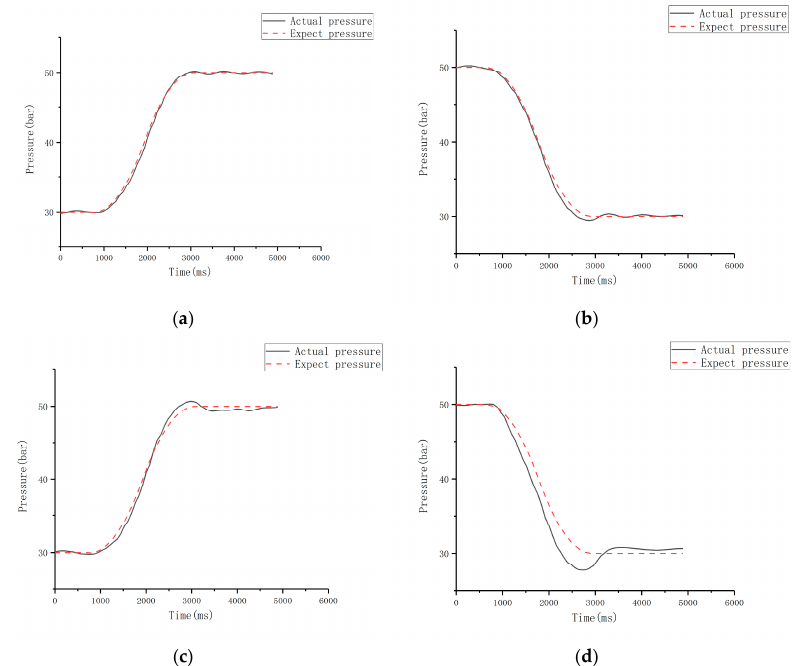
Figure 19. Pressure change curves when step signal changes from 30 bar to 50 bar and 50 bar to 30 bar. ( a ) Step rise curve of DTC based on sliding-mode control; ( b ) step descent curve of DTC based on sliding-mode control; ( c ) step rise pressure change curve of variable-speed pressure control; ( d ) variable-speed pressure control step-down pressure change curve. The pressure in the system when the given step signal changes from 10 bar to 50 bar and from 50 bar to 10 bar is shown in Figure 20. It can be seen from the experimental curve that the pressure control of the traditional variable-speed system still exhibits overshoot and hysteresis phenomena, and there is an obvious steady-state error, which is about ±4 bar. The pressure control response accuracy of the DTC system based on a sliding-mode variable structure is higher. The dynamic response and steady-state response errors are much smaller than in the traditional variable-speed system, the error is about ±1 bar, and the accuracy is improved by 2~3 bar, being better able to follow the expected pressure curve.